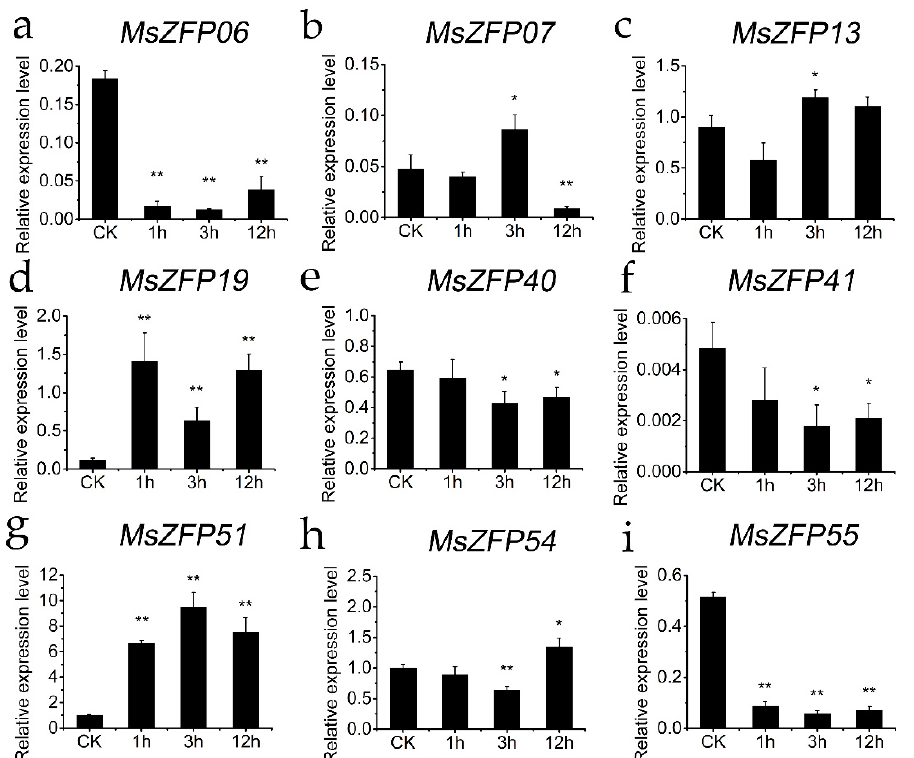
Figure 7. Expression analysis of nine MsZFP genes under ABA treatment, revealed by qRT-PCR. Values represent the average ± SD of root tips. Error bars represent the standard errors of the means ( n = 3). The relative expression level was normalized according to the values in the control (0 h). And a to i means the results of qRT-PCR of selected MsZFP s “*” indicates significance at the 0.05 level, and “**” indicates significance at the 0.01 level.